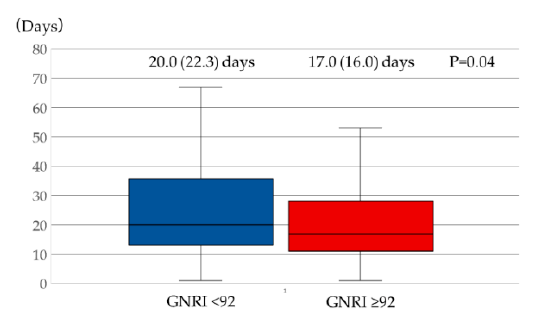
Figure 3. Comparison of length of hospital stay between patients with GNRI < 92 and ≥ 92 in HFpEF. Patients with GNRI < 92 showed longer length of hospital stay than those with GNRI ≥ 92. Mann–Whitney U-test was used for comparison between the two groups. Abbreviations: GNRI, Geriatric Nutritional Risk Index; HFpEF, heart failure with preserved ejection fraction. Table 6. Univariate and multivariate analyses of factors associated with longer length of hospital stay in HFpEF.